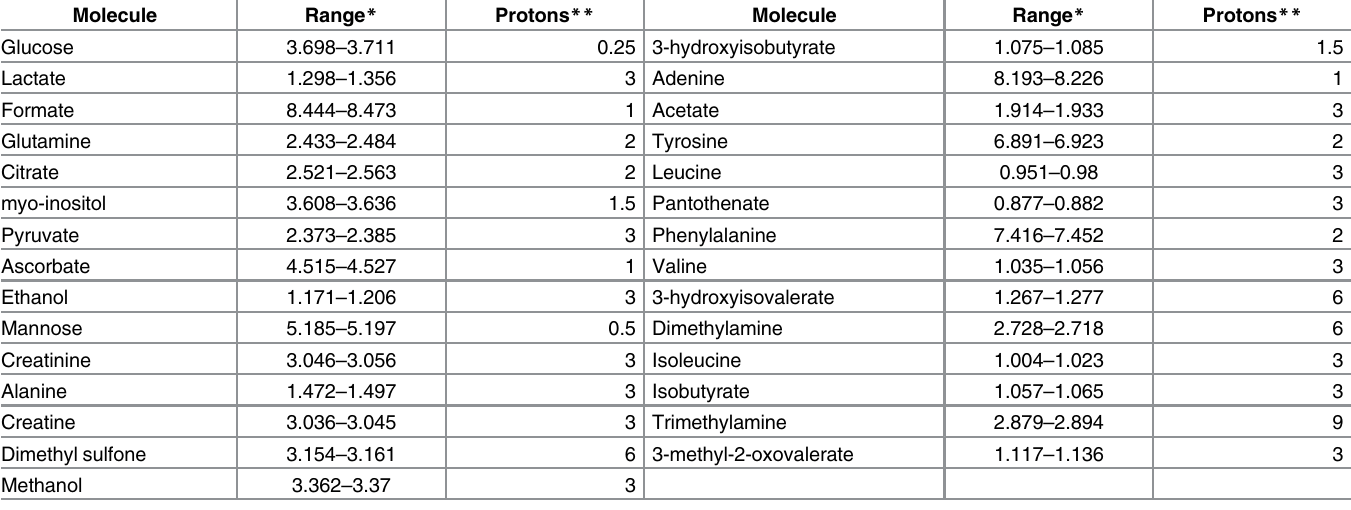
Table 1. Location of the NMR signals employed for molecules quantification, identified in CSF of pigs in the 5 – 50 days range